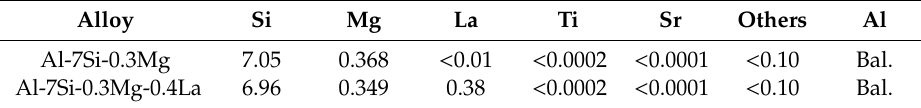
Table 1. Composition of Al7SiMg and Al7SiMg + 0.4La. (weight percent). Alloy Si Mg La Ti Sr Others